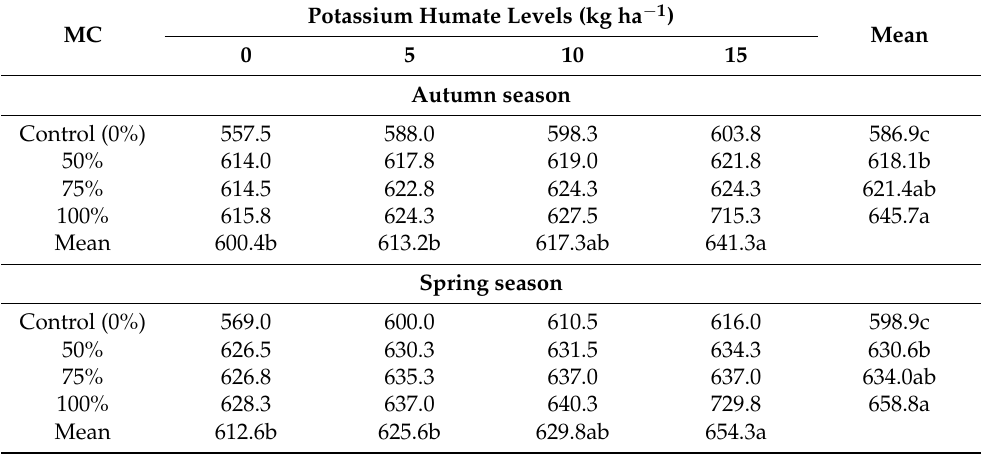
Figure 5. Interaction graphs for zinc concentration obtained in the tomato fruit under K-humate and micronutrients mixture applied in autumn and spring seasons. Table 7. Iron concentration (mg kg − 1 ) in tomato fruit as affected by various K-humate and MC mixtures under field conditions during